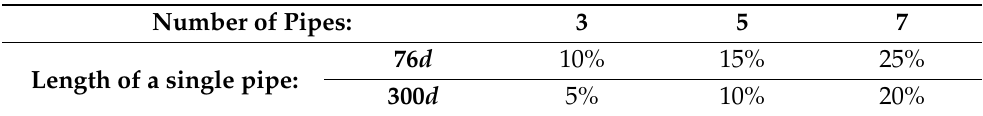
Table 5. Assumed percentage reduction in the thermal efficiency of a multipipe heat exchanger due to uneven air distribution among the